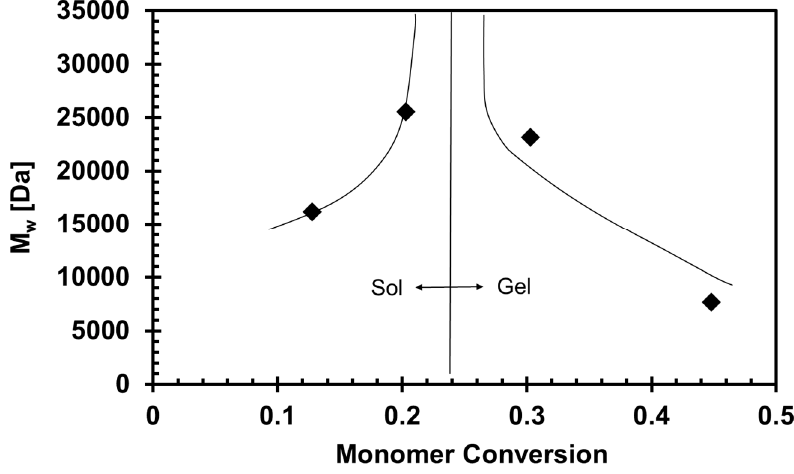
Figure 5. Evolution of M w for the NMC of STY/DVB in scCO 2 at [TEMPO]/[BPO] = 1.1, [DVB] = 1.5 wt.%, T = 120 ◦ C, and P = 207